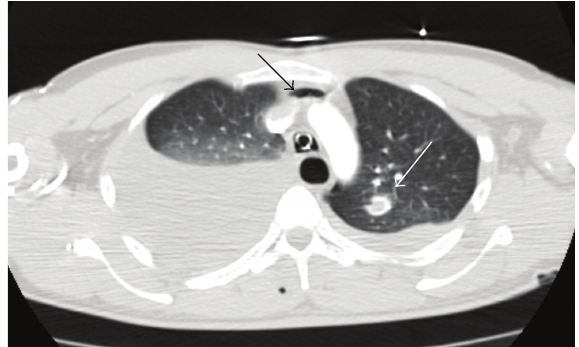
Figure 1: Contrast-enhanced axial chest CT using the lung window settings reveals bilateral hemothorax, minimal pneumothorax, and intraparenchymal hematoma in left lower laterobasal segment.